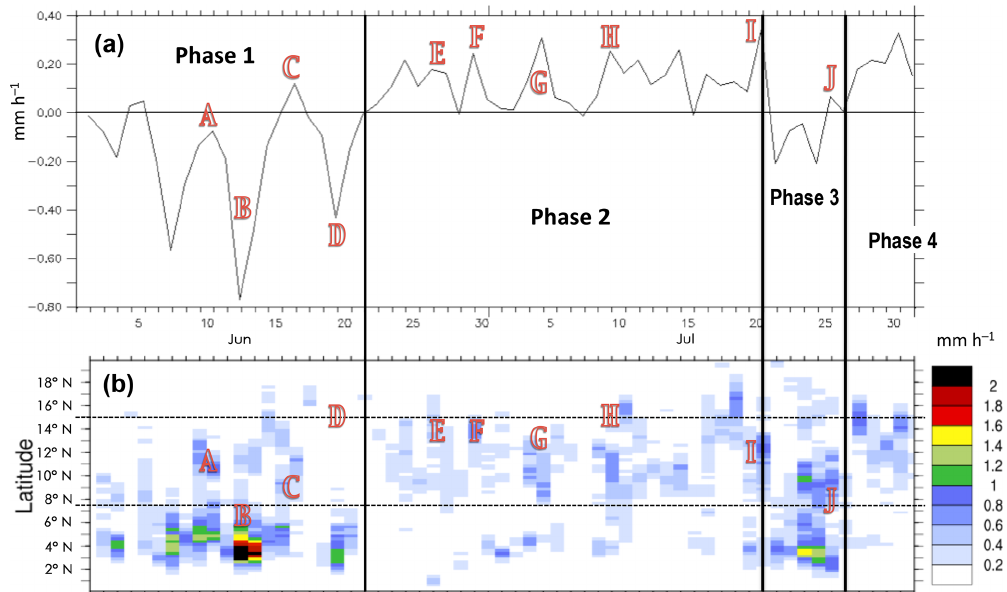
Figure 5. Rainfall evolution during June–July 2016. (a) North–south precipitation difference based on the 7.5–15 and 0–7.5 ◦ N bands (see boxes in Fig. 6). (b) Latitudinal distribution of rainfall. Both panels are based on daily TRMM precipitation values averaged over 8 ◦ W– 8 ◦ E (longitudes bordering DACCIWA focus region; see Fig. 1). The four phases of the DACCIWA campaign and significant synoptic-scale features A–J are marked at the approximate time (and also latitude in b ) of crossing the DACCIWA focus region.